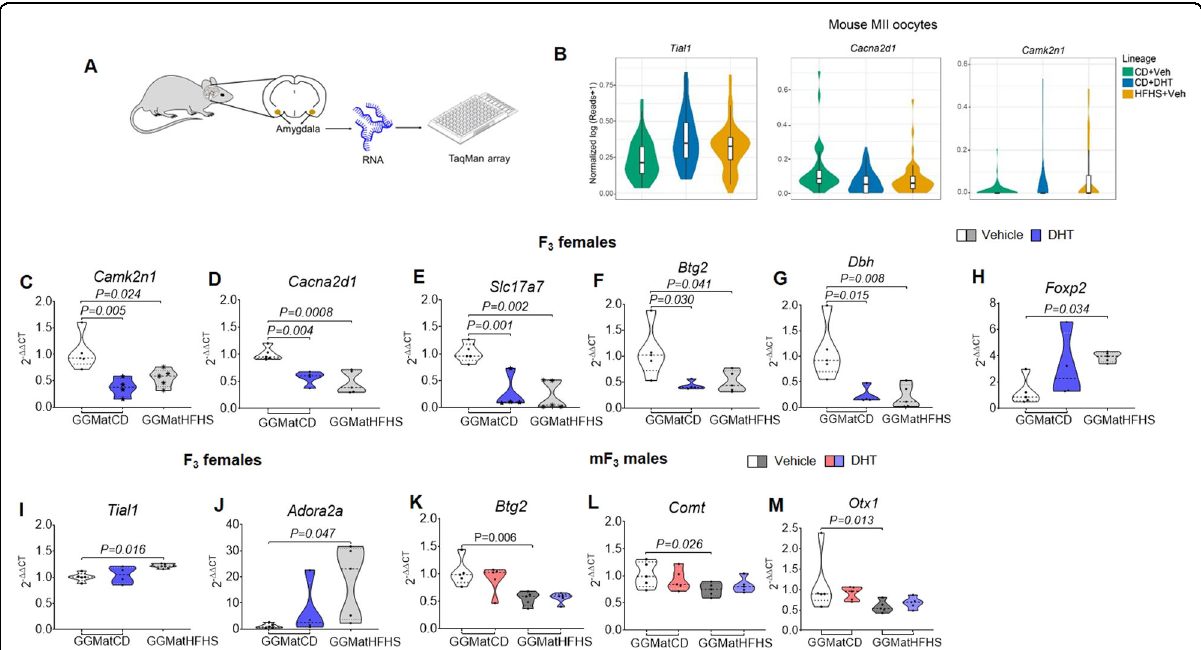
Fig. 4 Prenatal androgen exposure with and without maternal obesity causes anxiety-related gene expression changes in the amygdala of F 3 female and mF 3 male offspring. A Schematic illustration showing low-density TaqMan array of the amygdala. B Violin plots showing the expression level of selected DEGs in MII oocytes from each lineage. Violin plots showing the oocyte-speci fi c log-normalized gene expression in the y -axis of MII oocytes from each lineage (four animals per lineage; n = 42 oocytes in control diet + vehicle, n = 48 oocytes in control diet + DHT and n = 47 oocytes in HFHS + vehicle). C – M Violin plots showing on the y -axis gene expression by 2 − ΔΔ CT of C Camk2n1 , D Cacna2d1 , E Slc17a7 , F Btg2 , G Dbh , H Foxp2 , I Tial1 , J Adora2a , K Btg2 , L Comt , and M Otx1 in the amygdala of C – J F 3 female offspring (control lineage n = 5, androgenized lineage n = 4, and obese lineage n = 5) and K – M mF 3 male offspring (control lineage n = 5, androgenized lineage n = 5, obese lineage n = 5 and obese and androgenized lineage n = 5). The data are present in violin plot ( C – J ) showing the frequency distribution curves. The median and quartiles values are shown in dotted and dashed lines, respectively. Two-way ANOVA was followed by Bonferroni post hoc analysis and one-way ANOVA by Bonferroni post hoc analysis. All data are presented as mean ± s.e.m. DHT dihydrotestosterone, CD control diet, HFHS high-fat high-sugar, GGMat great-grand